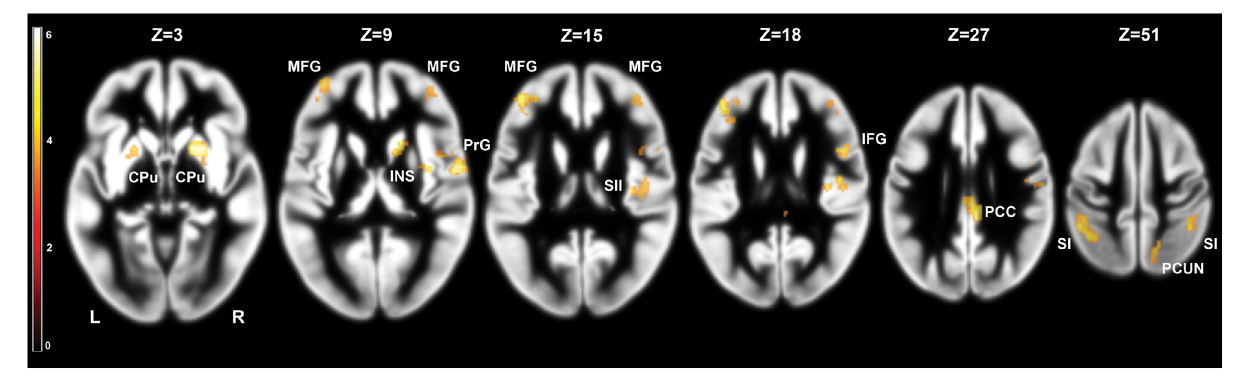
FIGURE 3 | Brain activity pattern in the whole group ( n = 29) associated with the effect of frustration induction on Braille characters discrimination task (Braille II vs. Braille I). CPu, caudate-putamen; MFG, middle frontal gyrus; PrG, precentral gyrus; INS, insula; SII, secondary somatosensory cortex; SI, primary somatosensory cortex; PCC, posterior cingulate cortex; PCUN, precuneus; L, left side; R, right